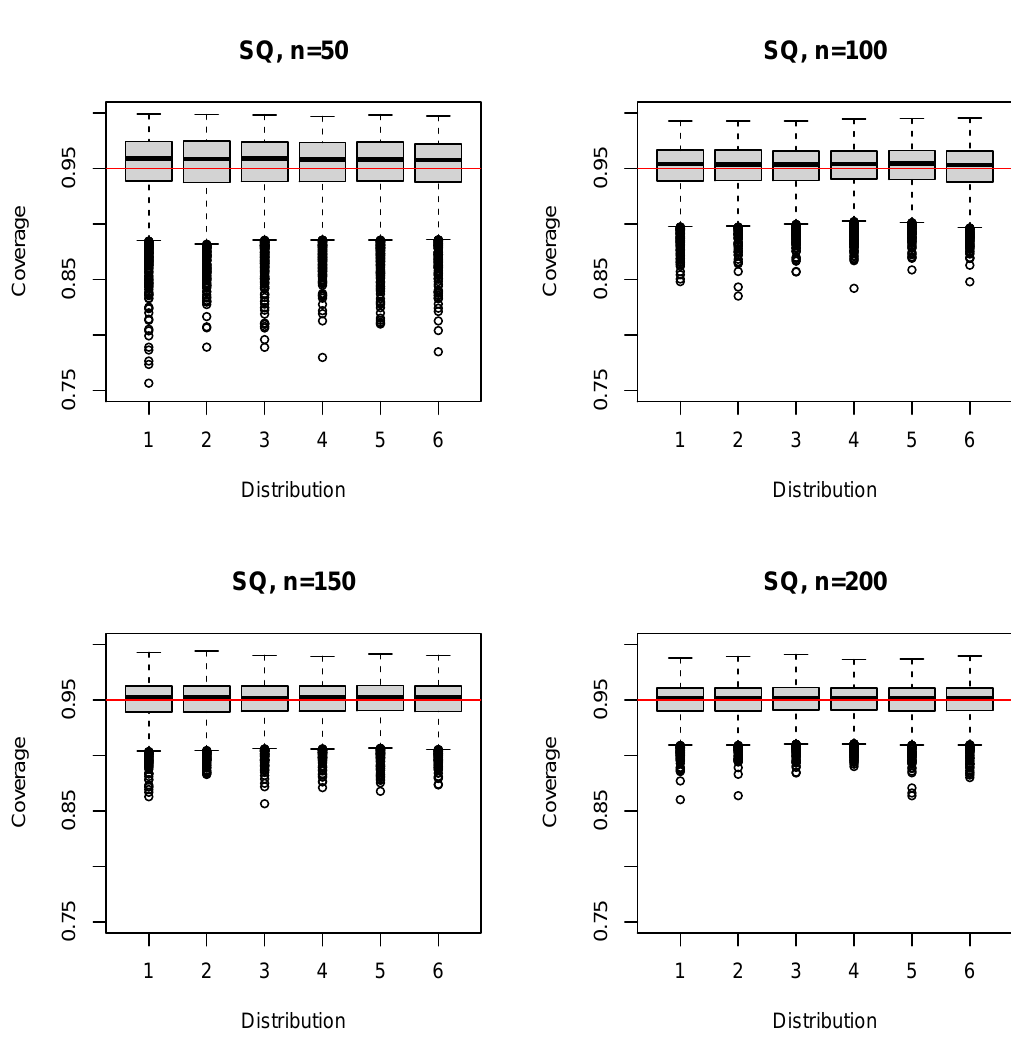
Figure 4. Boxplots of the coverage probability for the SQ estimator and n = 50 ( 50 )